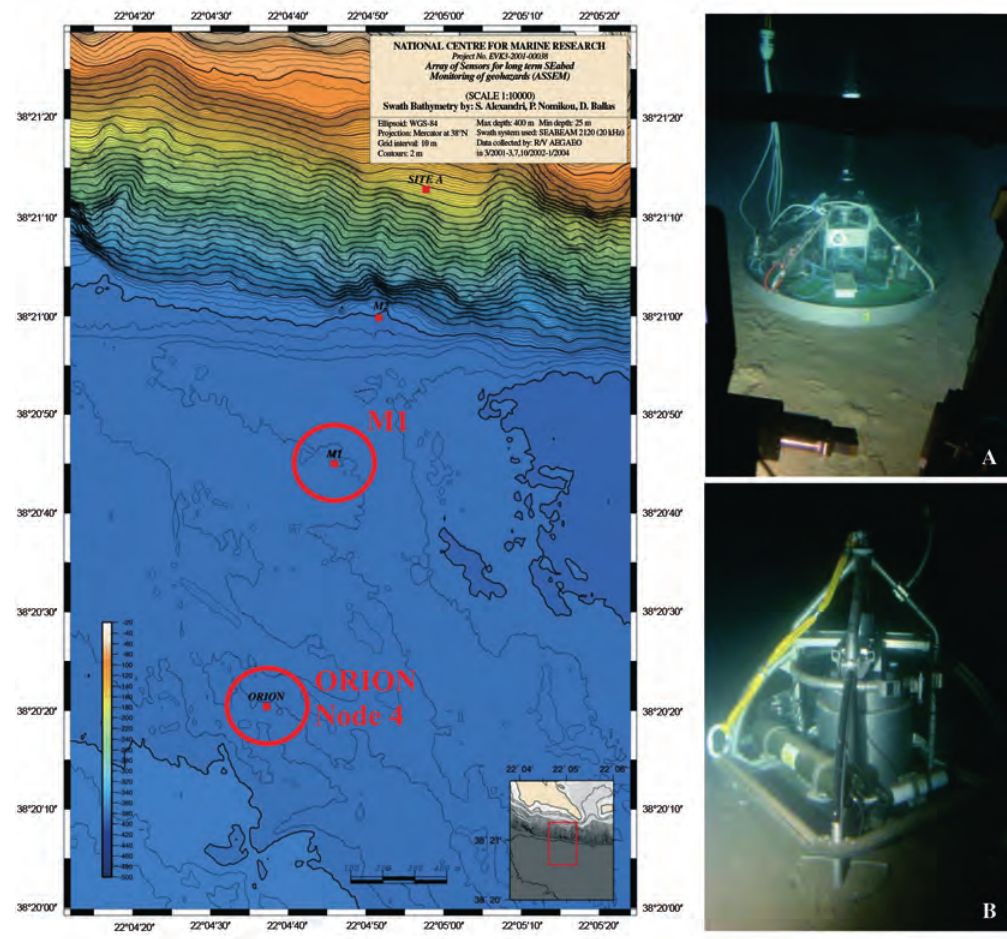
Fig. 10. Bathymetric map of the Gulf of Corinth where one of the ASSEM pilot experiments was carried out. The dots represent the locations of the underwater nodes, the two red circles indicate the M1 node (A, underwa- ter photograph on the right); and the ORION-GEOSTAR-3 Node 4 (B, underwater photograph on the right) (Blandin et al. ,